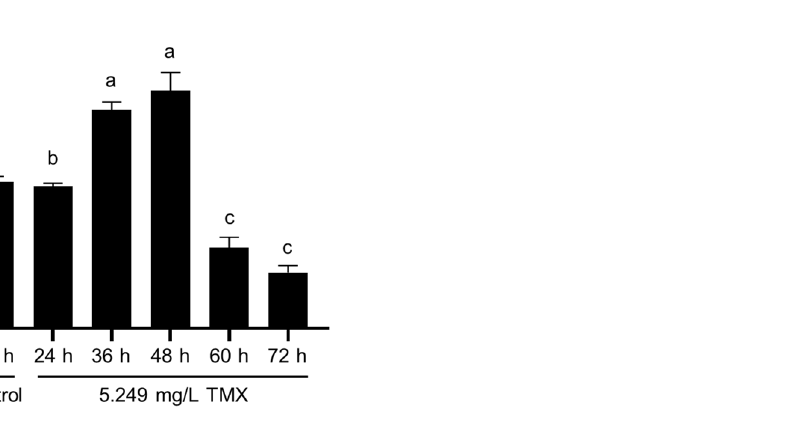
Figure 6. The expression levels of synapsin were changed during exposure to TMX. The letters above each column indicate significant differences (Tukey’s multiple comparison test, p < 0.05).